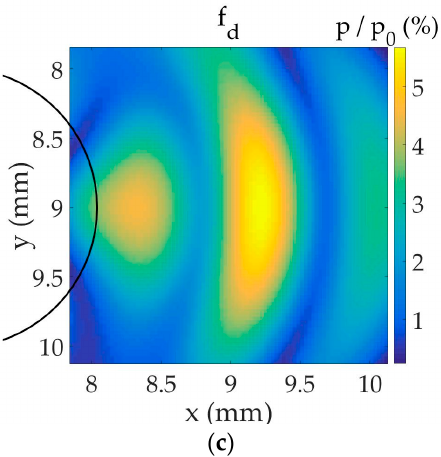
Figure 6. Amplitude distribution, expressed in % of pressure at the source, of the two primary frequencies (for which the same color range is used) and the difference frequency (for which a specific color range is used) within the squared area shown in Figure 5. The bubble region boundary is shown with the black line. ( a ) f 1 ; ( b ) f 2 ; ( c ) f d